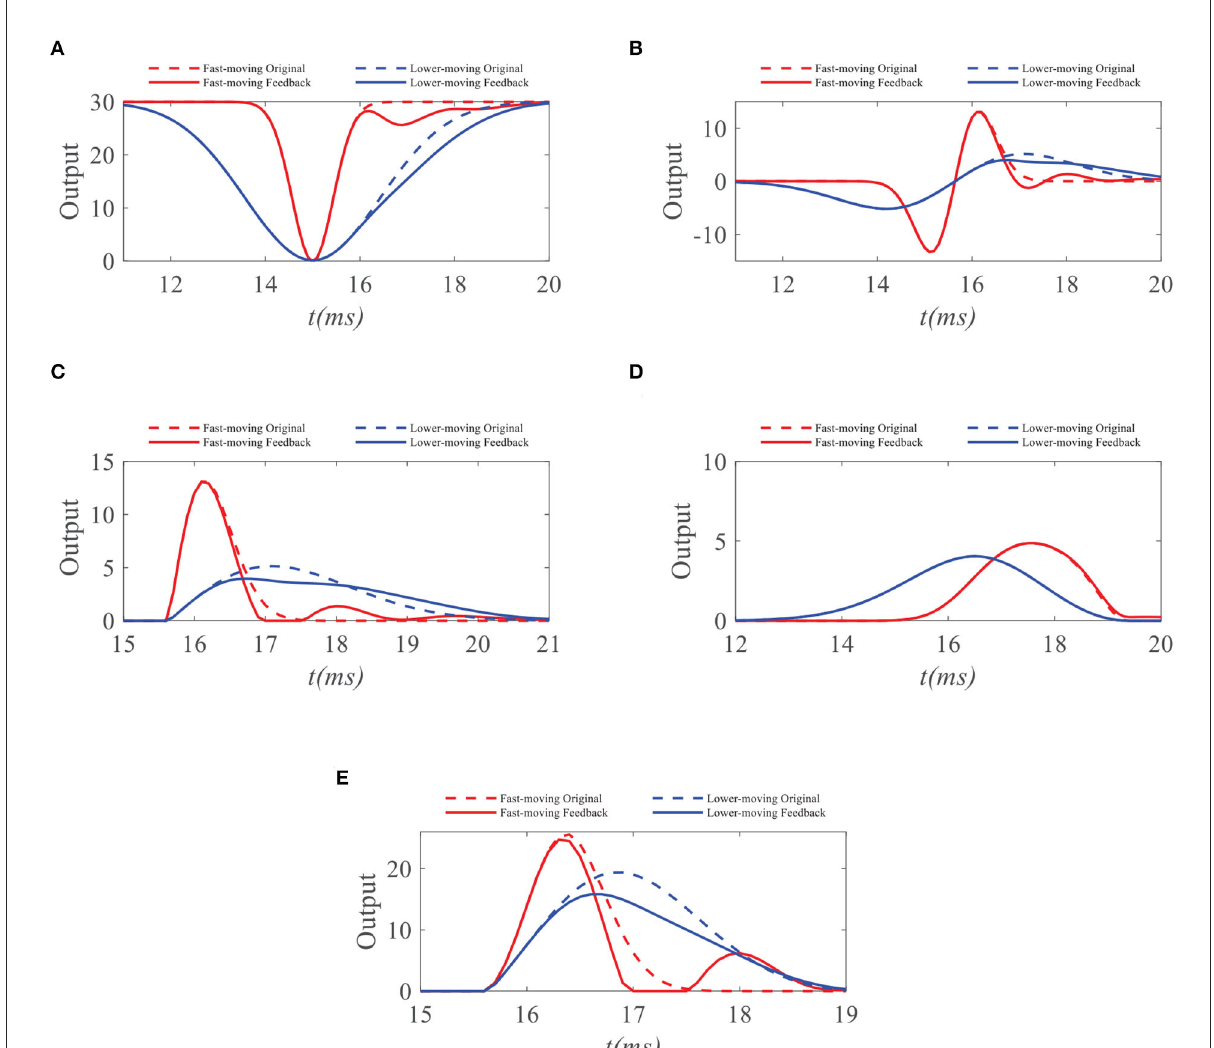
FIGURE5 (A) Original ommatidia outputs and feedback ommatidia outputs to small targets with different velocities. The feedback signal weakens the ommatidium output to the slow-moving target in the second half of its response duration. In contrast, the ommatidium output to the fast-moving target receives minor inhibition from the feedback signal. Meanwhile, feedback signals have no effect on small targets with different velocities in the first half of their response durations, since STMD neuron has not yet responded when the small target enters the pixel point. (B) Original LMC outputs and feedback LMC outputs to small targets with different target velocities. The peak value of LMC output for fast-moving target maintains unchanged and the peak value of LMC output for slow-moving target has declines. (C) The original ON outputs and feedback ON outputs to small targets with different target velocities. The peak value of ON output to lower-moving target reduces, but the peak values of ON outputs to fast-moving target hardly change. (D) The original OFF outputs and feedback OFF outputs to small targets with different target velocities. (E) The peak values of OFF outputs to target with different velocities hardly change. The original STMD outputs and feedback STMD outputs to small targets with different target velocities. The STMD output reduction with a fast-moving target is significantly lower than